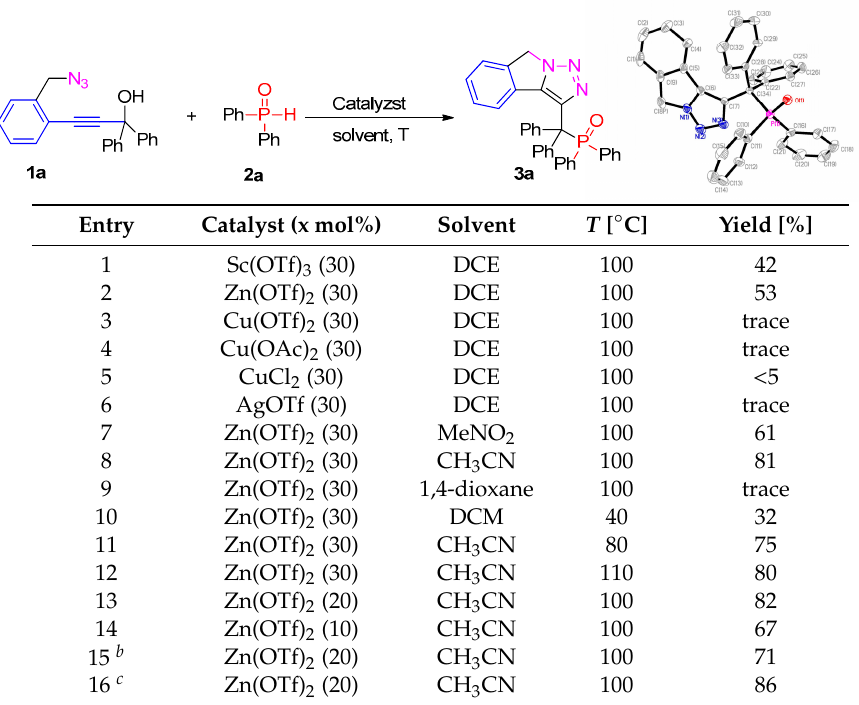
Table 1. Optimization of the reaction for the synthesis of 3a a .